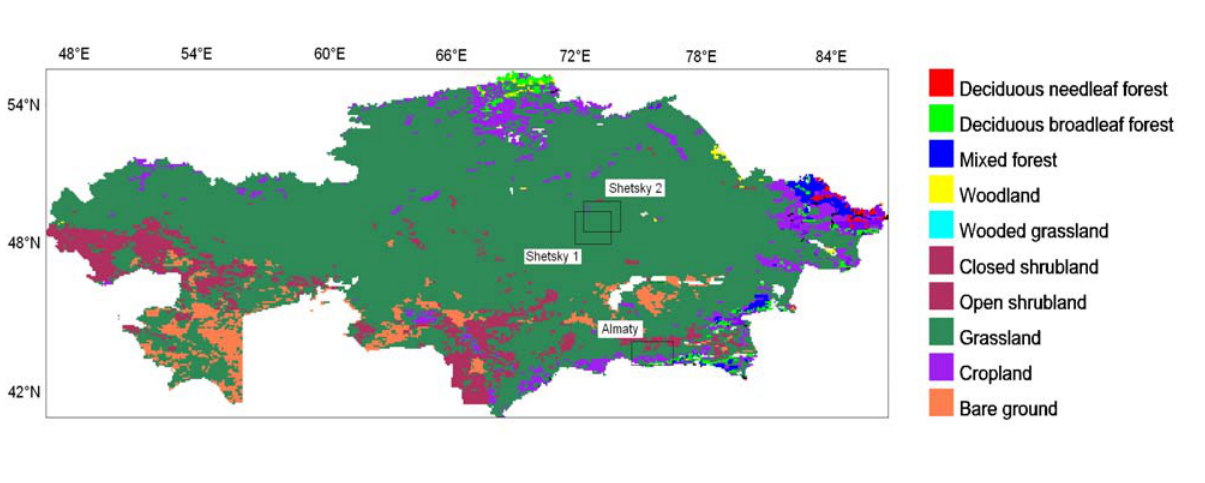
Figure 1. Classification of current vegetation for the Republic of Kazakhstan based on the 8-km Advanced Very High Resolution Radiometer (AVHRR) LANDCOVER 1981–1994 global map [45]. Test sites for in situ measurements are presented by squares and